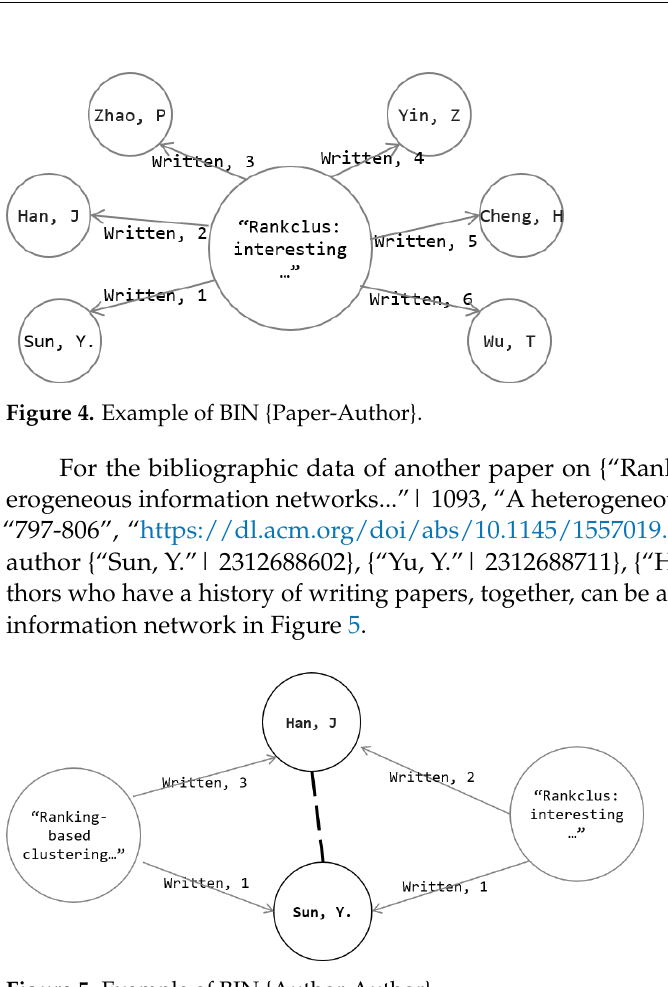
Figure 5. Example of BIN {Author-Author}.